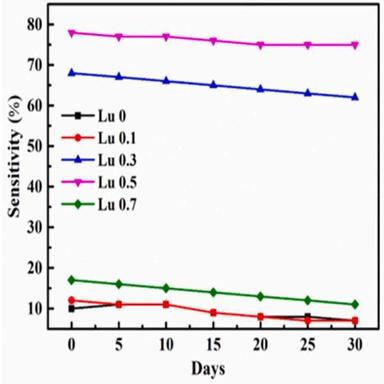
Sensitivity v/s Day of ZnFe(2-x)LuxO4 where x = 0.01(Lu 0.01), 0.03(Lu 0.03), 0.05(Lu 0.05), 0.07(Lu 0.07).